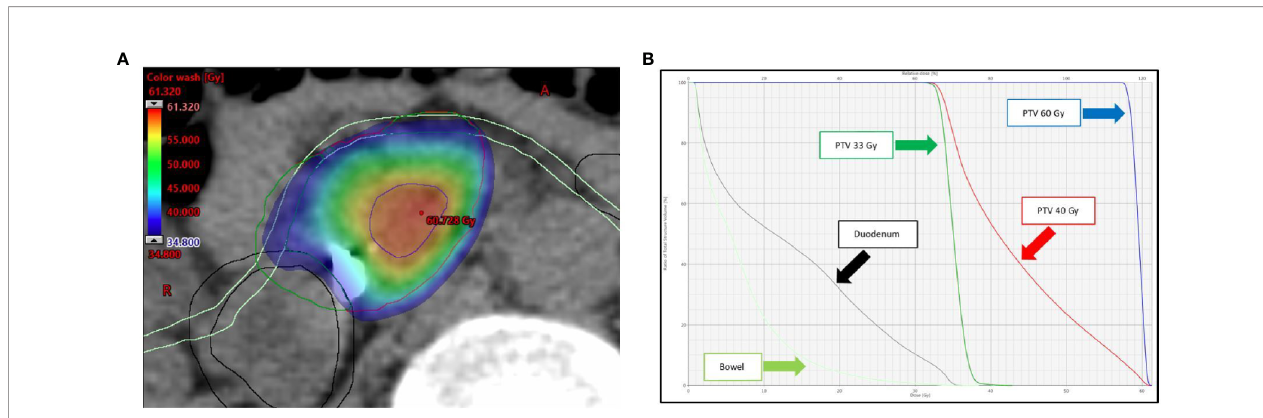
FIGURE 3 | (A) Dose distribution (color wash) and (B) dose-volume histogram (DVH) for the single SBRT plan showing a minor acceptable deviation for bowel and duodenum (D 0.5cc = 34.8 Gy). As shown in panel A, the anatomy for this lesion is rather unfavorable, with the simultaneous protection volume (PTV sip , dark green ), surrounded for almost two thirds of the circumference by the PRVs. The following structures are shown: tumor planning target volume (PTV t , red ), high-dose planning target volume (PTV sib , blue ), duodenum ( black ), and bowel ( light green ). The Planning at Risk Volume (PRV oars ) are shown with same color on axial image.